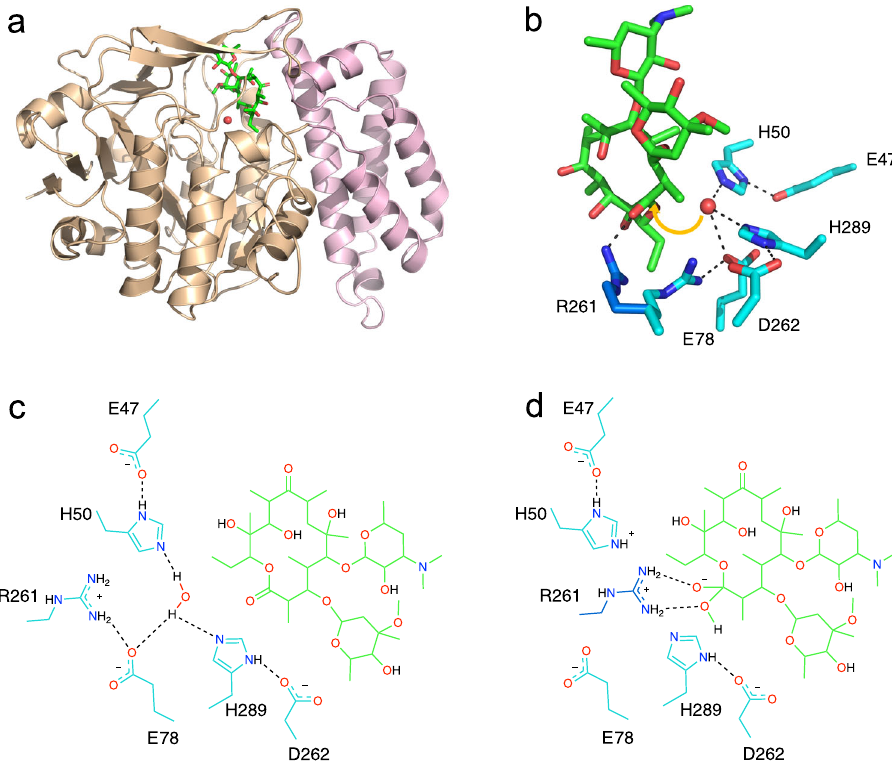
Fig. 2 Predicted binding mode of erythromycin. Erythromycin modeled into the WT EreC Closed model showing catalytic amino acids and the interactions between the residues and the substrate. a Modeled structure of EreC Closed with erythromycin and water. The major lobe is displayed in light brown and the minor lobe in light pink. b A three-dimensional representation where protein residues are colored in teal, modeled alternate side-chain conformation of R261 in dark blue, erythromycin in green, and water molecule in red. The arrow indicating where the water molecule will attack erythromycin is shown in yellow. c Two-dimensional representation displaying the residues implied in the catalytic activity together with erythromycin. The color scheme of carbon atoms is the same as in ( b ) . d Modi fi cation of ( c ) showing modeled alternate side-chain conformation of R261, and how it can interact with the transition state.